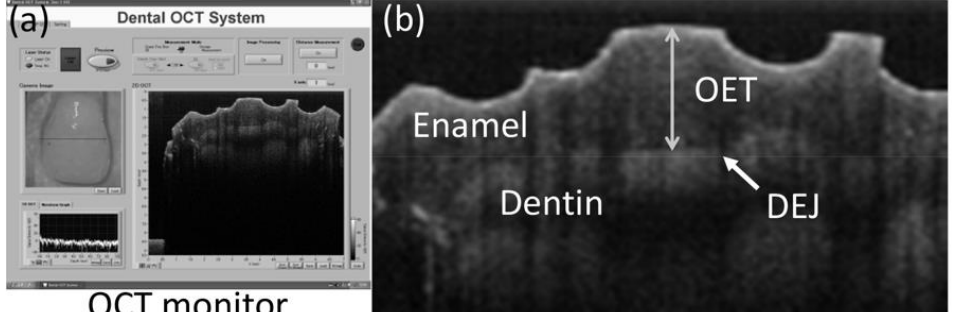
Figure A3. ( a ) Obtained OCT image; ( b ) Enlarged OCT image obtained. The distance from the middle of the marks to the edge was measured as the optical enamel thickness (OET) perpendicular to the tangent of the middle of the marks. Next, enamel thickness ( e1 ) was calculated by dividing the optical thickness values obtained by 1.63.